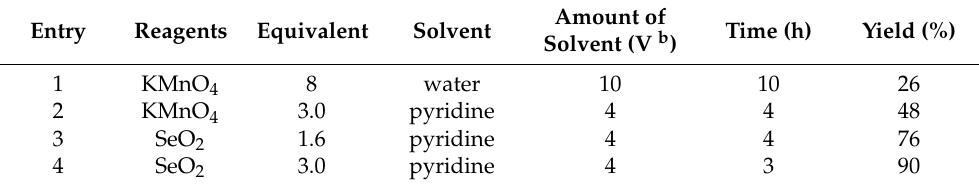
Table 1. Optimization of the oxidation reaction of compound 4 to carboxylic acid 5 a .